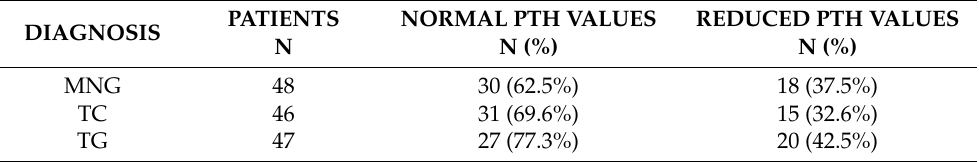
Table 4. Post-operative serum PTH, by thyroid